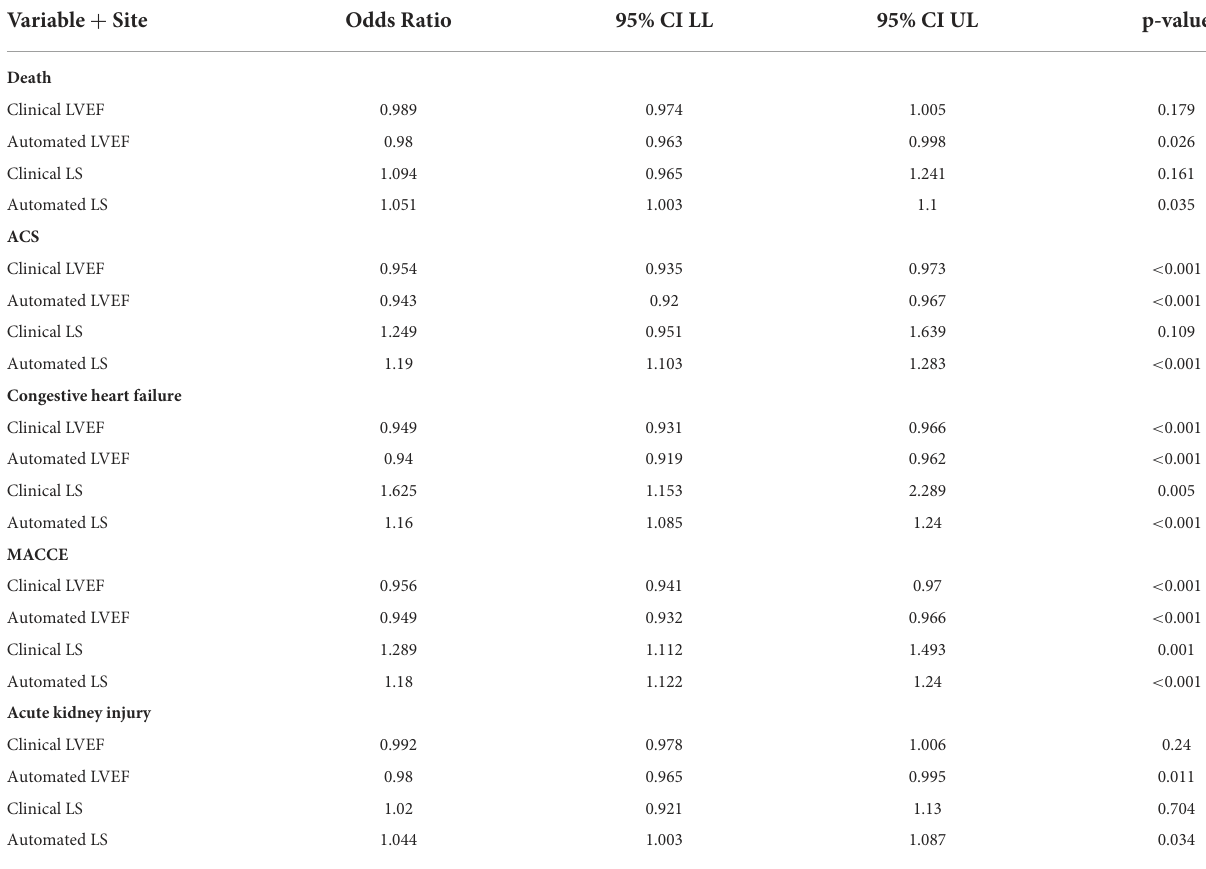
TABLE 4 Site adjusted univariate logistic regression of automated and clinical LVEF and LS and clinical outcomes. Variable +